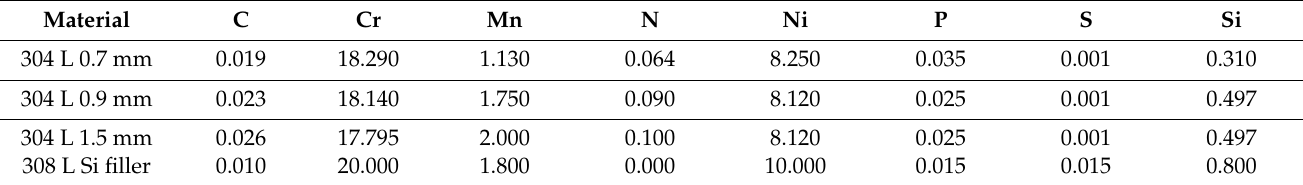
Table 1. Chemical composition of the materials used in the experiments.